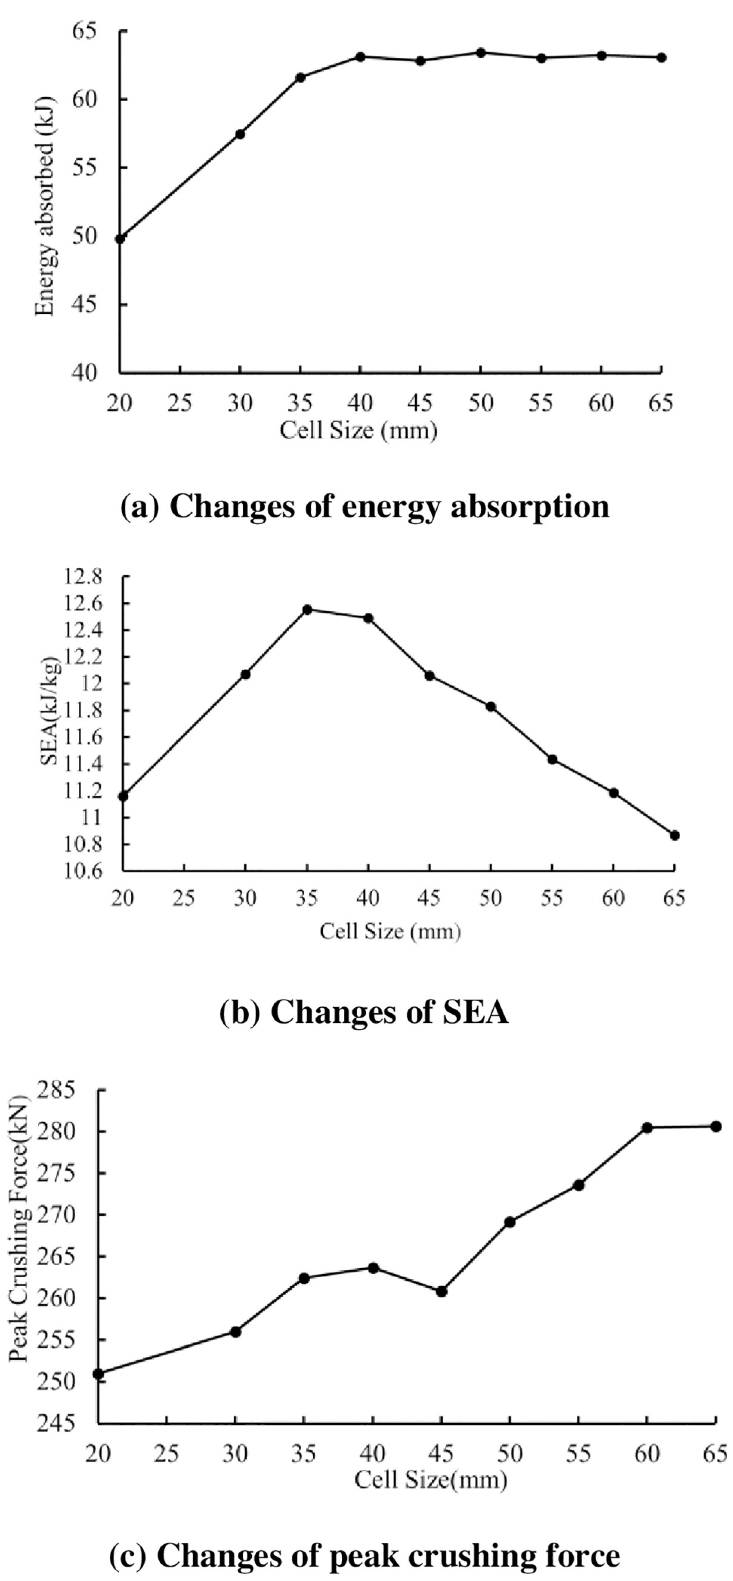
Fig 10. Effect of the corner-cell size of the energy absorption and crushing characteristics. https://doi.org/10.1371/journal.pone.0233708.g010 PLOS ONE | https://doi.org/10.1371/journal.pone.0233708 June 8,